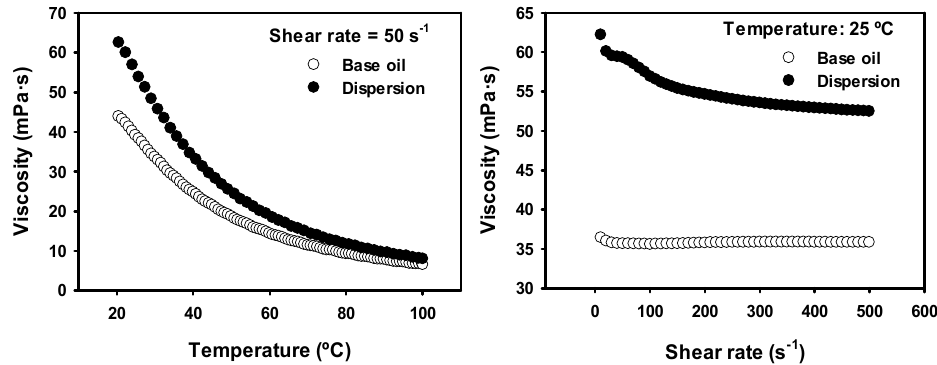
Figure 6. Viscosity variation with temperature and with shear rate for both lubricants.